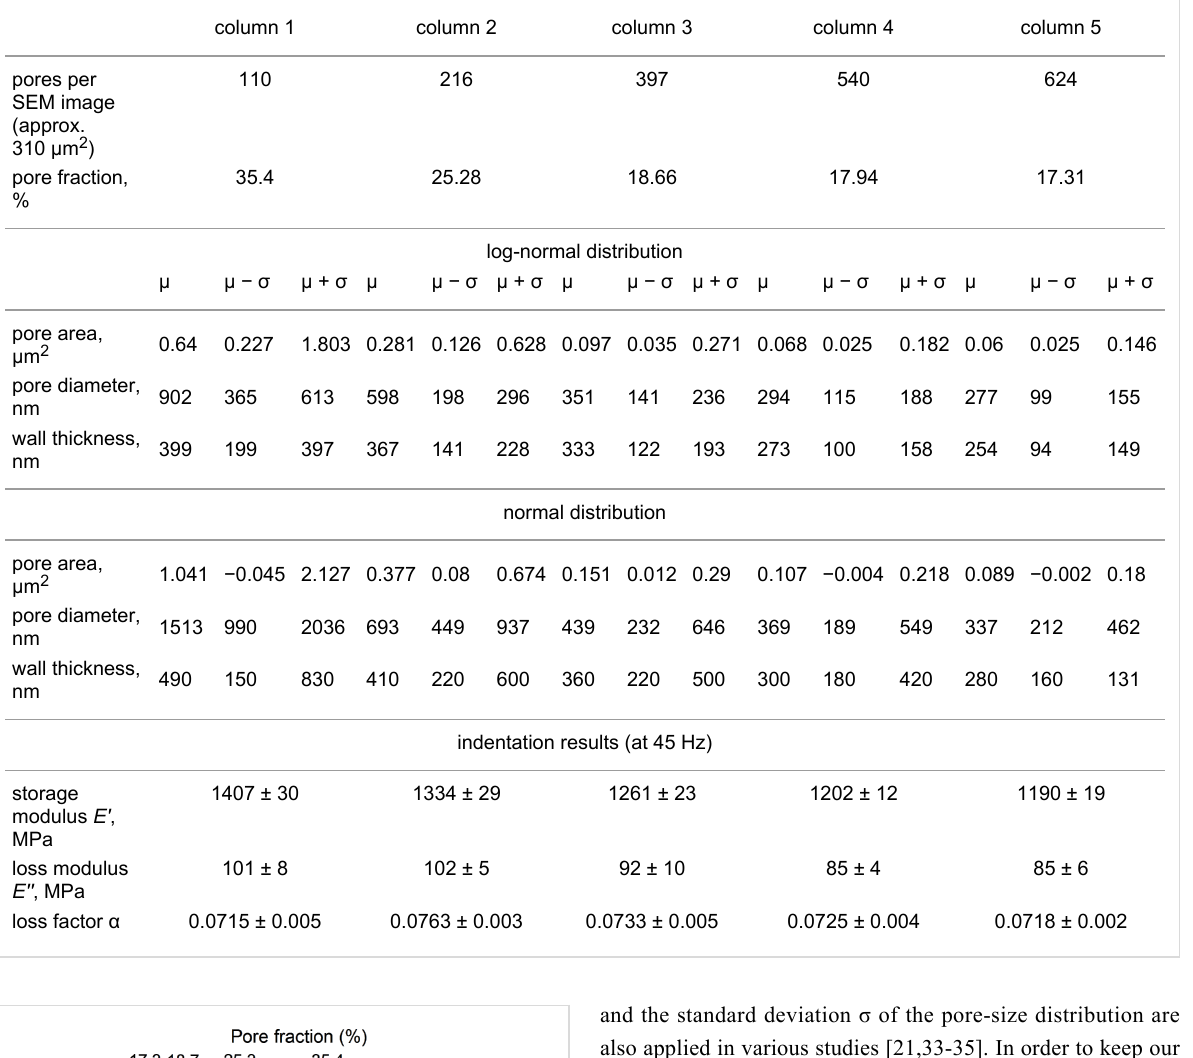
and the standard deviation σ of the pore-size distribution are also applied in various studies [21,33-35]. In order to keep our results comparable, the average dimension parameters and their standard deviations are also given in Table 1. The values of the arithmetic mean ( μ ) are always bigger than those of the geometric mean. However, the overall relation between the values does not change with the statistical model. The values for storage modulus and loss modulus as well as the